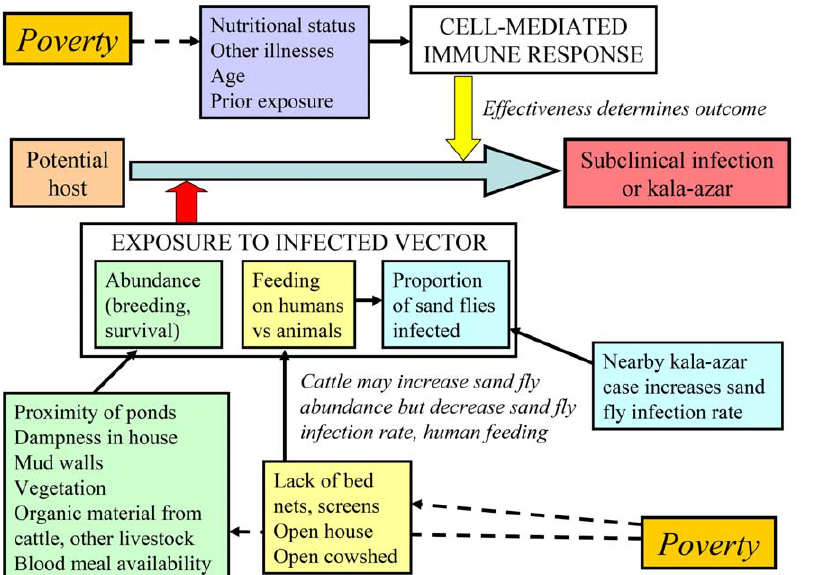
Figure 1. Diagram of the interplay of factors that affect risk of kala-azar and asymptomatic Leishmaniadonovani infection in South Asia. Kala-azar risk is increased by proximity to the infectious reservoir host (an untreated kala-azar patient) and by exposure to infected sand flies, but may be decreased by behaviors such as bed net use that interrupt human-sand fly contact or host factors such as diet that affect the immune response to the parasite. Cattle may affect risk in complex ways, through their effect on sand fly abundance, breeding, infections rates and feeding frequency on humans.